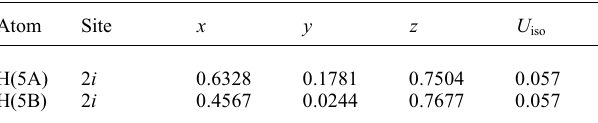
Table 2. Atomic coordinates and displacement parameters (in Å 2 ) .